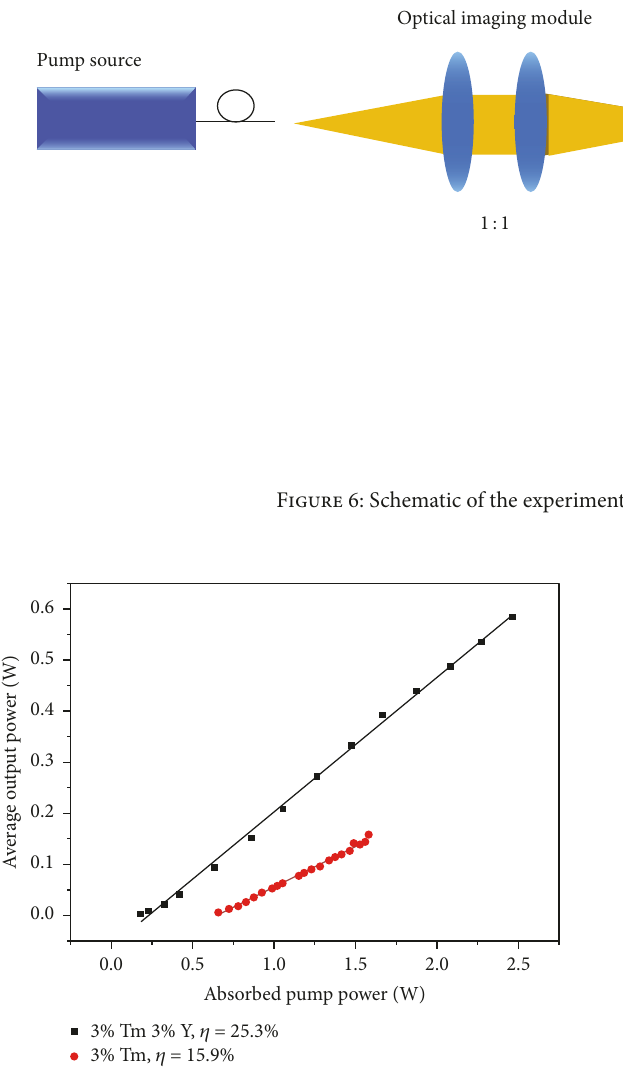
Figure 7: Laser output power versus absorbed pump power curve for 3 at.% Tm:CaF 2 and 3 at.% Tm, 3 at.% Y:CaF 2